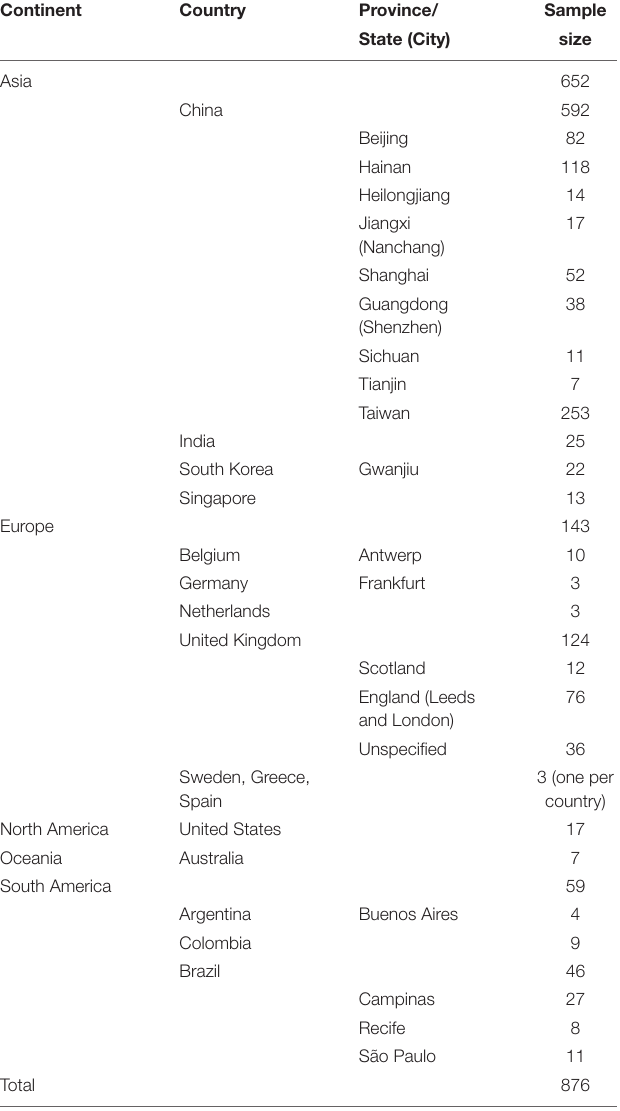
TABLE 1 | Distribution of the geographic populations of Candida tropicalis analyzed in this study. Continent Country